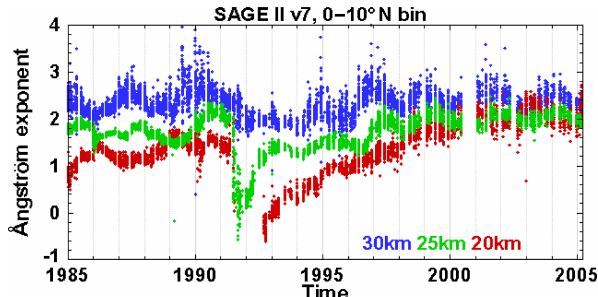
Figure 1. Time series of the SAGE II Ångström exponent (AE) de- rived from the aerosol extinction coefficients measured at 525 and 1020nm for altitudes of 30km (blue), 25km (green), and 20km (red). This figure shows SAGE II Version 7.0 data for the 0–10 ◦ N latitude band during the period from 1986 to 2005. While the Pinatubo eruption in 1991 produced a significant decrease in the AE, the smaller volcanic eruptions, such as Ruang and Reventador in 2002 and Manam in 2005, which are visible in the extinction time series (not shown), did not appreciably affect AE values. The AE values appear to stabilize after 2000, suggesting that a back- ground state exists. The AE is quite scattered at 30km compared with lower altitudes, which is related to the reduced quality of the aerosol retrieval for low aerosol